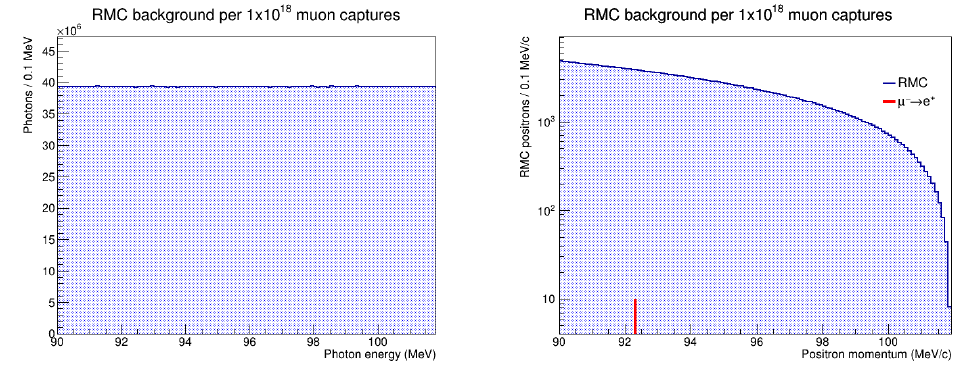
Figure 5. Assumed on-shell RMC photon spectrum high energy tail on aluminum for 10 18 muon captures ( left ) and the corresponding positron spectrum using the simplifying assumptions about the conversion spectrum and track reconstruction ( right ). The signal process is also shown using the same tracking efficiency for a sample R µ − e + value of 10 − 16 , which would likely be discoverable in the absence of an RMC